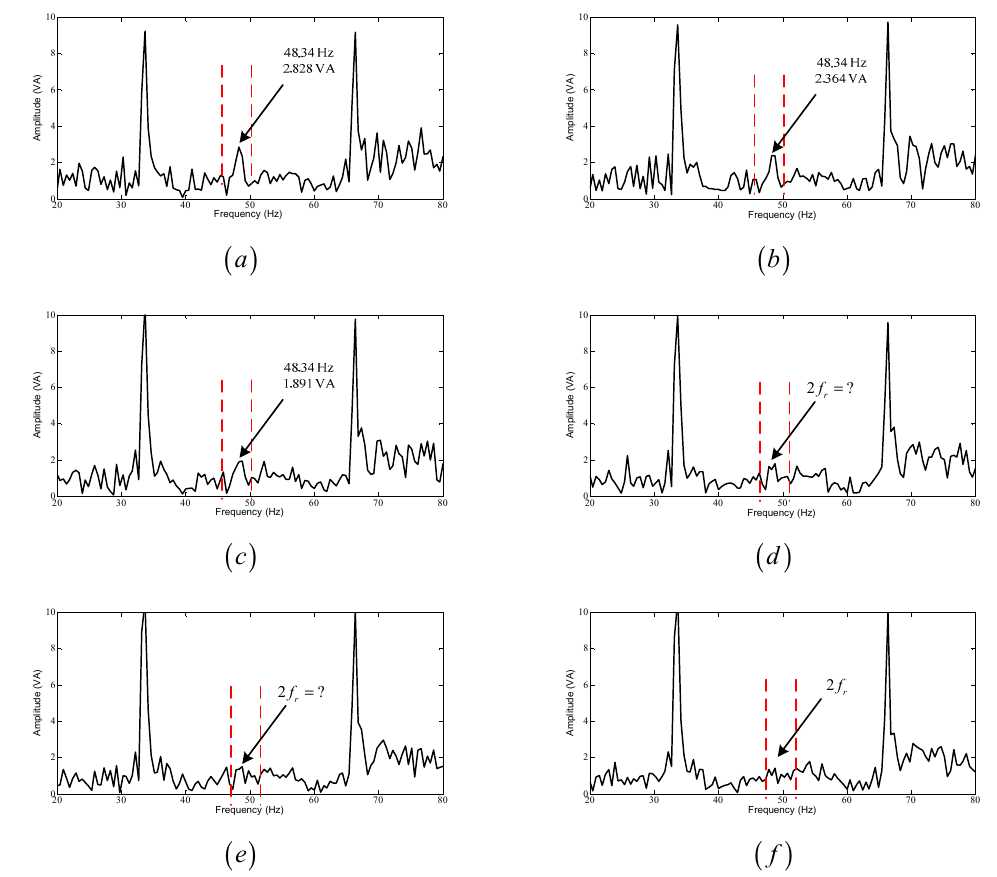
Figure 4. FFT spectrum of apparent power with six different levels of dynamic eccentricity under full load (simulation): ( a ) 10% DE, ( b ) 8% DE, ( c ) 6% DE, ( d ) 4% DE, ( e ) 2% DE, and ( f ) healthy.